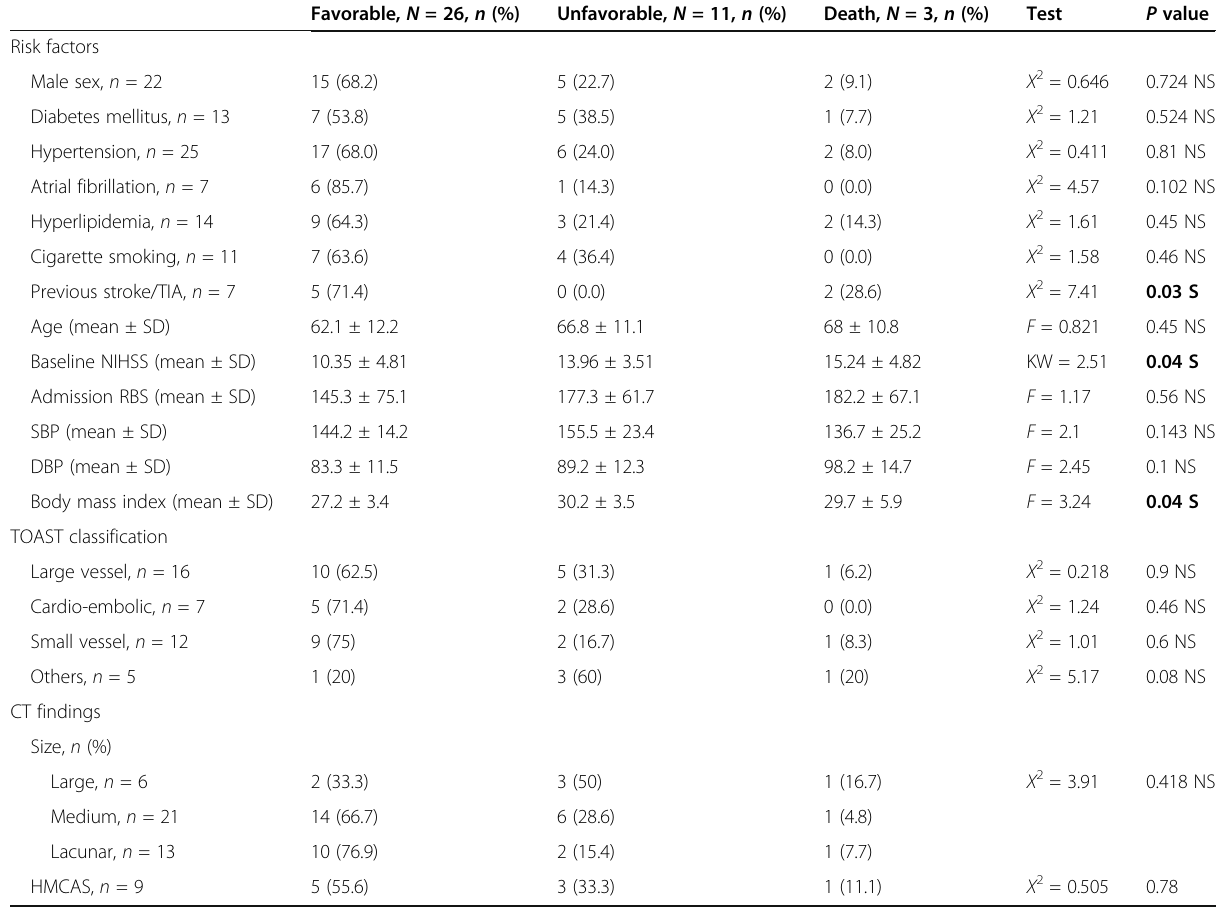
Table 4 Three months outcome among thrombolyzed AIS patients in relation to baseline characteristics Favorable, N = 26, n (%) Unfavorable, N = 11, n